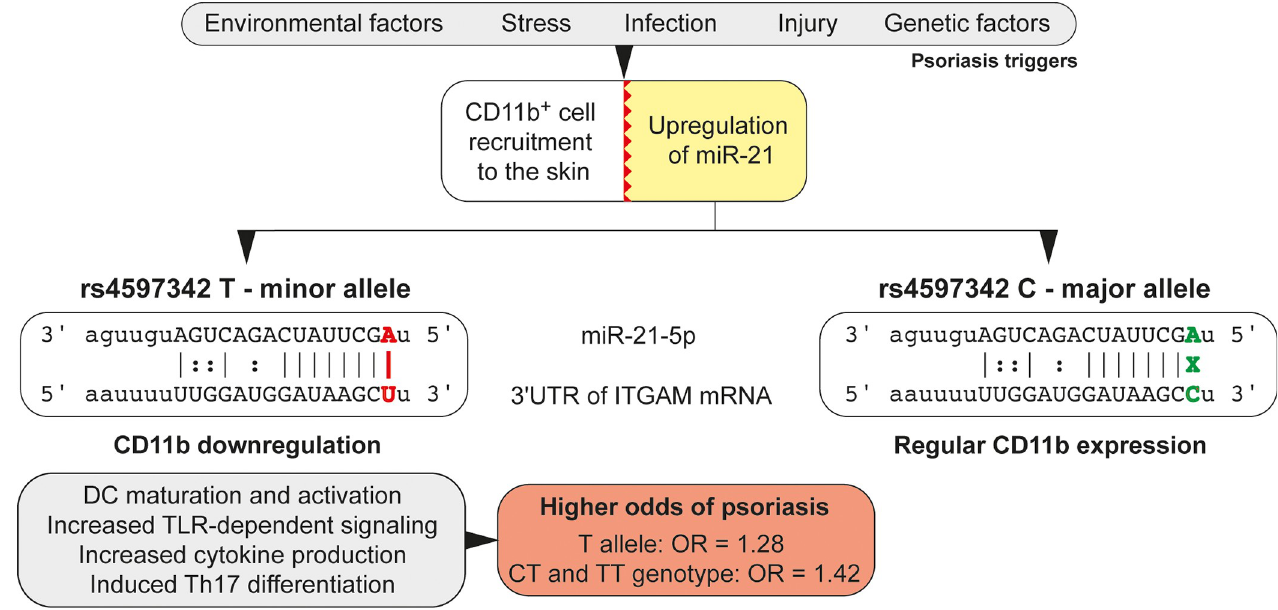
Fig 1. rs4597342 proposed mechanism of psoriasis susceptibility.